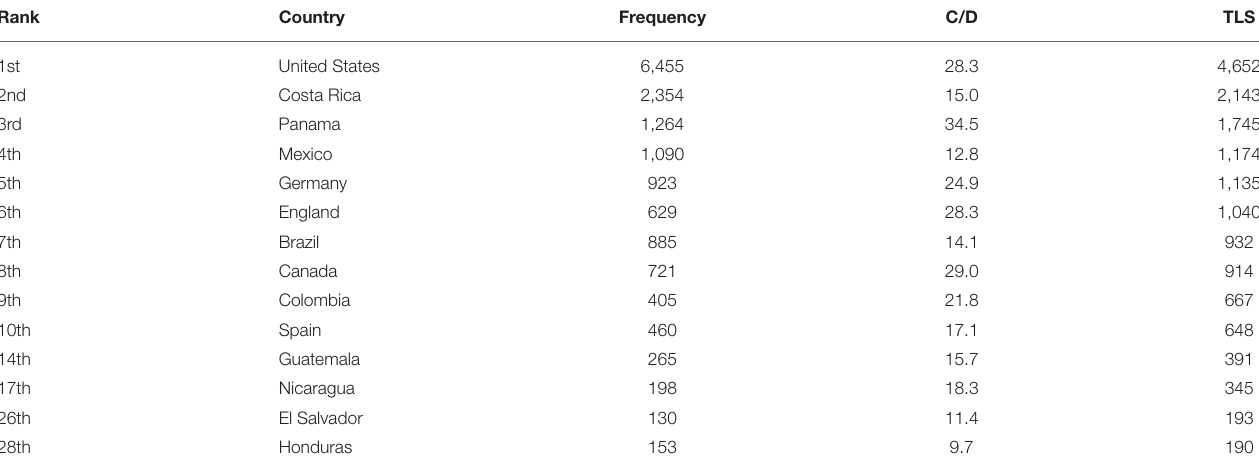
TABLE 2 | Top ten publishing countries in biodiversity topics in Central America. Rank